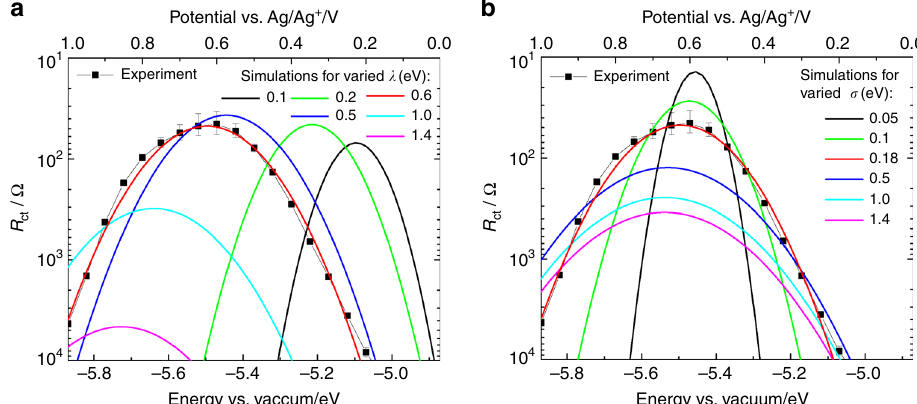
Fig. 5 Effect of the distributions of electronic states in electrolyte and polymer on the charge-transfer resistance according to the Marcus – Gerischer model. a Experimental charge-transfer resistance (black symbols, with error bars showing the fi tting uncertainty) and simulated charge-transfer resistances (colored lines) for varied reorganization energy λ of the electrolyte at fi xed width σ = 0.18 eV of the Gaussian polymer DOS. b Experimental (black symbols with fi tting uncertainty as error bars) and simulated (colored lines) R ct for varied σ at fi xed λ of 0.6 eV. Other simulation parameters were N = 10 21 cm − 3 (number of states per unit volume), E ct = − 5.45 eV (center of the Gaussian distribution), A = 0.4 cm 2 , k t = 1.6 × 10 − 22 cm 4 s − 1 , c red = 6 × 10 17 cm − 3 , E 0 (FcDM 0/+ ) = +0.07 V vs. Ag/Ag + (or − 4.94 eV), and T = 298 K. The red curves correspond to a simulation using the reorganization energy of the best fi t shown in Fig. 4 ( λ = 0.6 eV) together with the Gaussian DOS width that best describes the experimental DOS of the polymer ( σ = 0.18